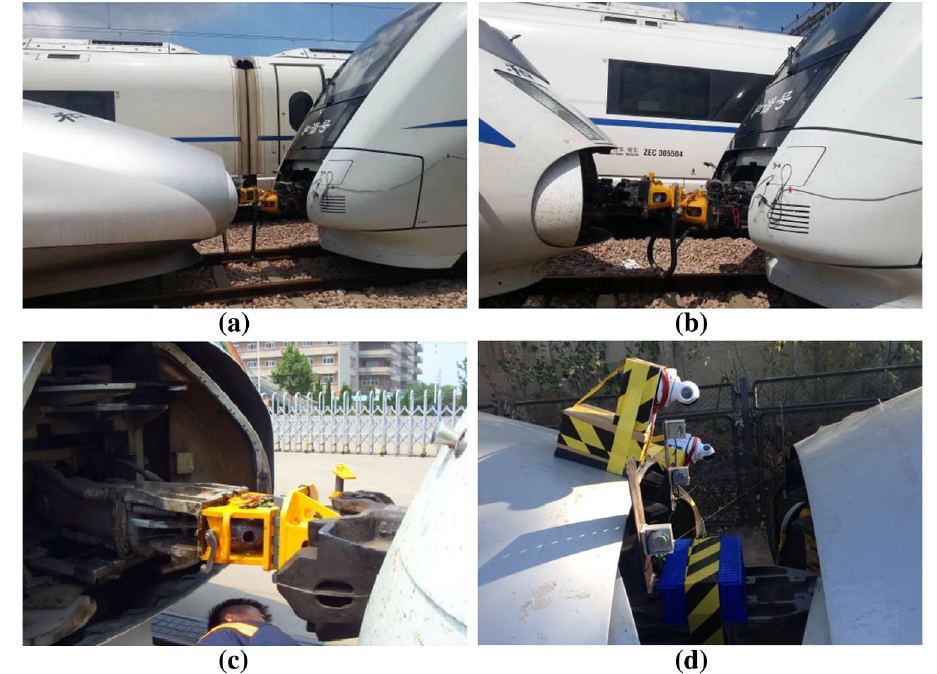
Fig. 2 Field tests of coupled multiple units under rescue scenarios. a CRH1A–CRH380A. b CRH380BL–CRH1A. c CRH2E–CRH1B. d CRH380A–CRH380A